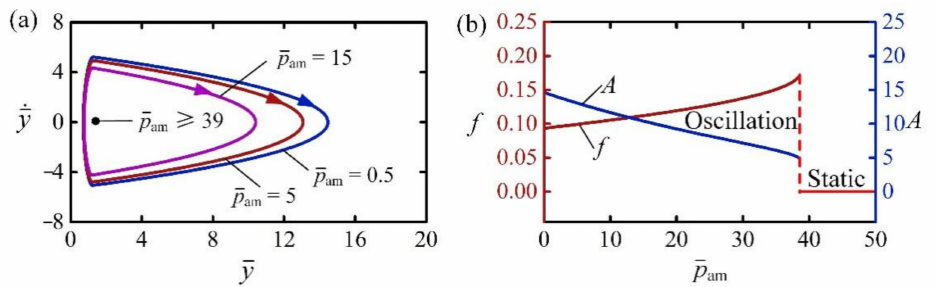
Figure 12. The effect of ambient pressure on the self-jumping, for I 0 = 2, C 0 = 0.3, H = 4, β = 0.01, . = 30, and = 0. ( a ) Limit cycles. ( b ) Frequency and amplitude. As g = 1, n g = 200, E = 500, y y 0 0 p increases, the frequency of self-jumping increases while the amplitude am